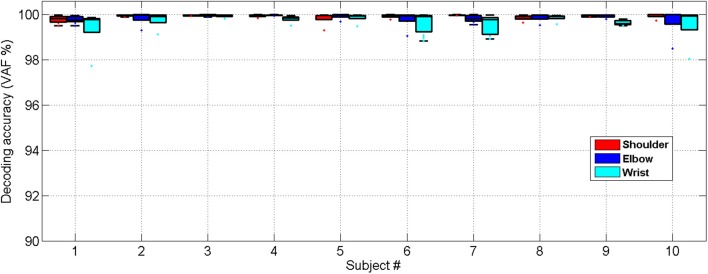
Cross-validated position decoding performance characterized by the VAF over all able-bodied subjects.